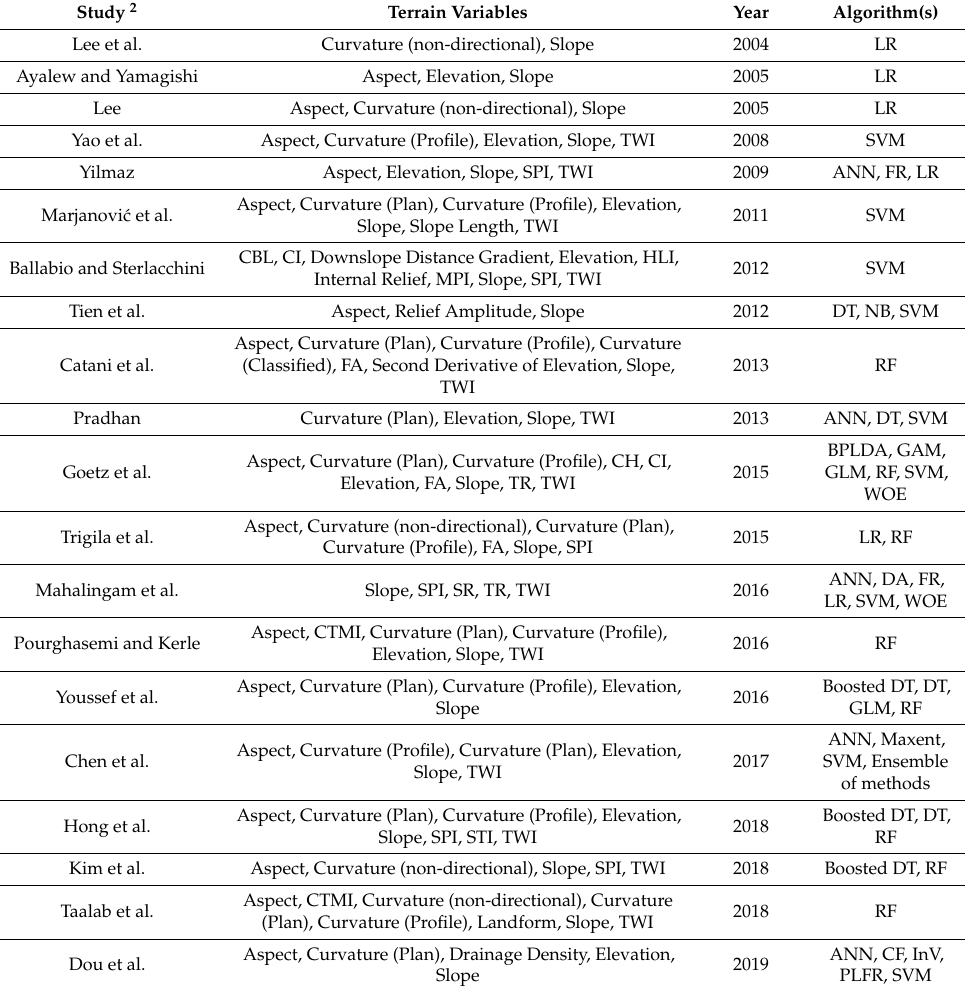
Table 1. Example of terrain variables used in slope failure mapping or susceptibility studies 1 . Study 2 Terrain Variables Year